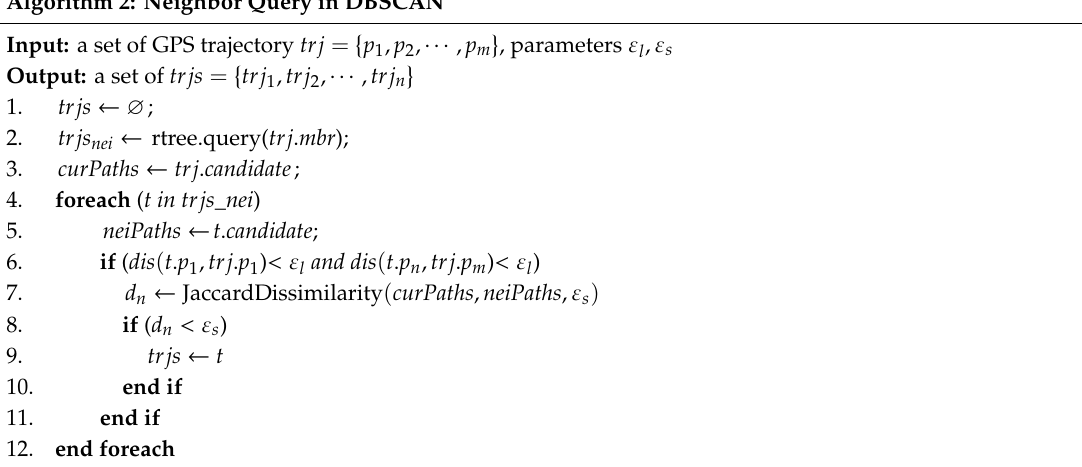
Algorithm 2: Neighbor Query in